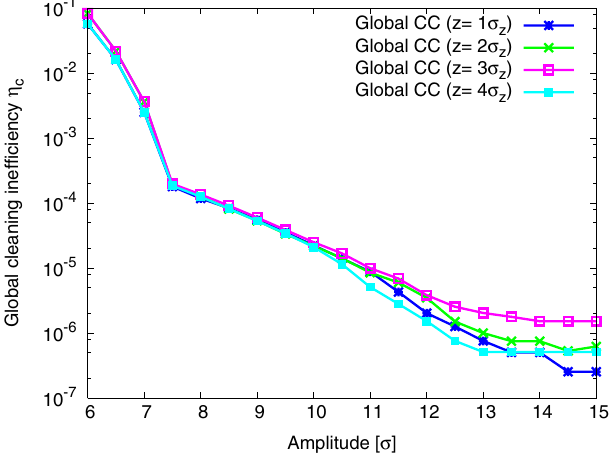
FIG. 14. (Color) Global cleaning inefficiency for LHC top en- ergy, (cid:4) (cid:3) IP1 ; 5 ¼ 0 : 55 m , with the 800-MHz global crab cavity: beam halo with z ¼ 1 (cid:7) z (blue); beam halo with z ¼ 2 (cid:7) z (green); beam halo with z ¼ 3 (cid:7) z (magenta); beam halo with z ¼ 4 (cid:7) z